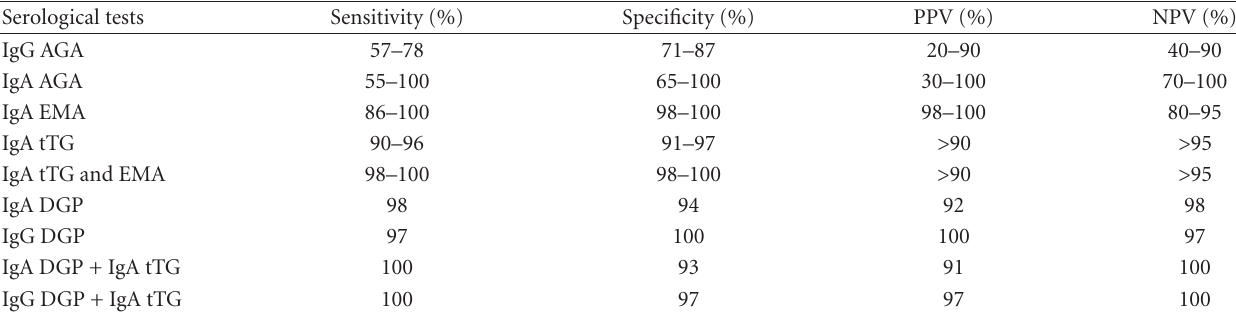
Table 3: Characteristics of exclusive or combined serological tests used to detect CD [11, 13, 18, 32].